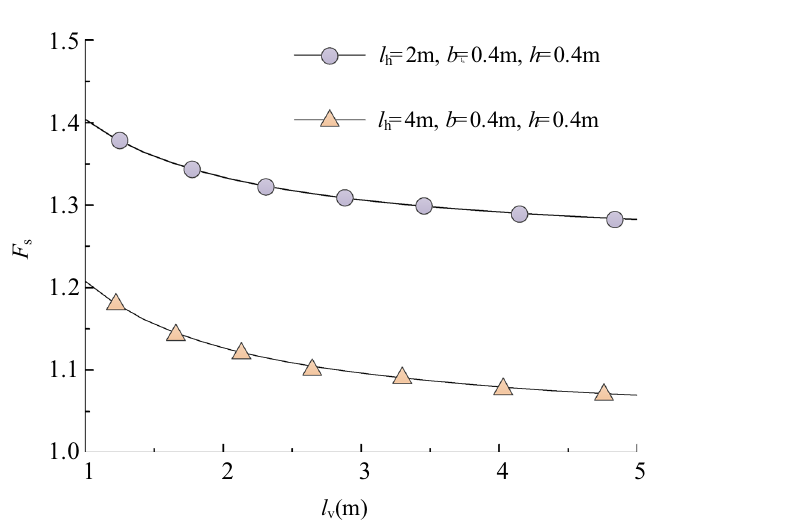
Figure 11. F s change with l v (slope ratio = 1.5, z w = 1.2